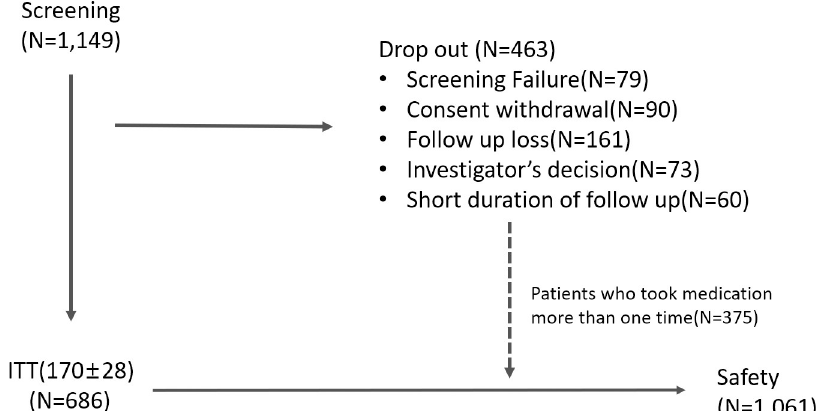
Fig 1. Study population. A total of 1,149 patients were screened for the study and 686 patients who took the study medication for 24 weeks were included in the intention-to-treat analysis. A total of 1,061 patients who took study drug more than once were included in the safety